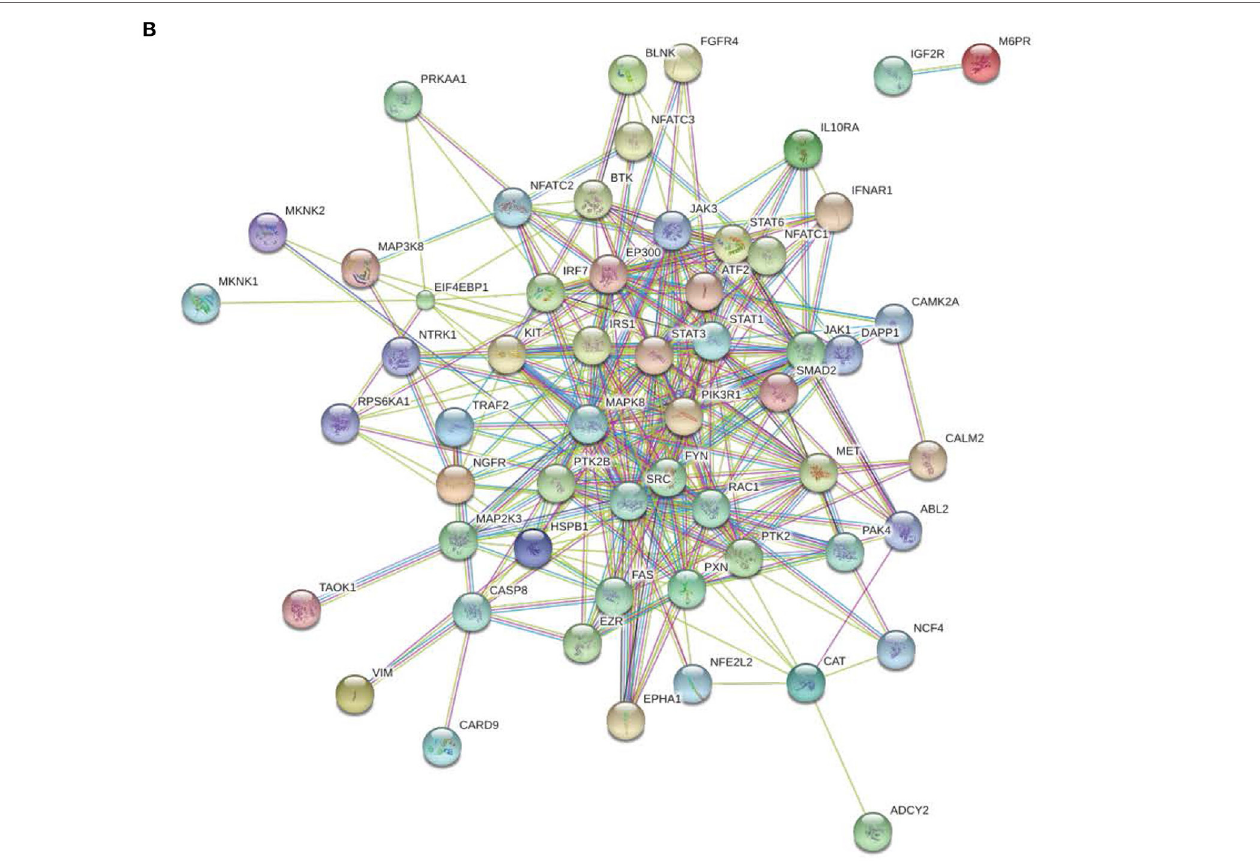
FigUre 2 | Protein–protein interactions. Predicted protein–protein interactions generated following analysis of significantly different peptides input into the STRING database: (B) early high interactions.